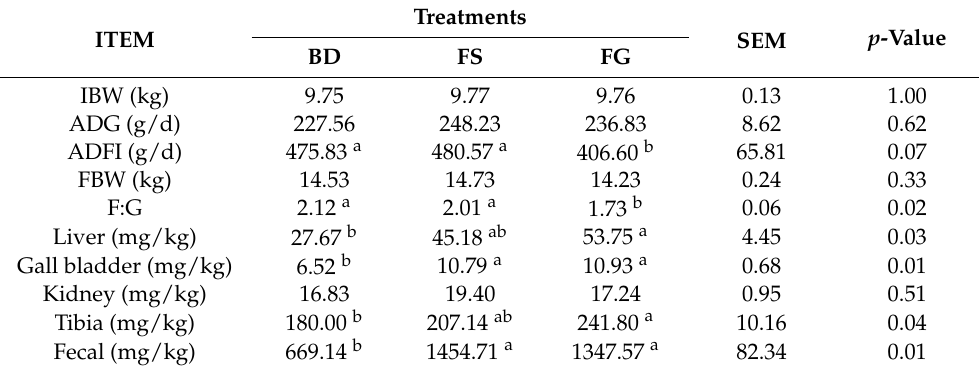
Table 1. Effect of different iron sources on growth performances and iron deposition in weaned pigs.